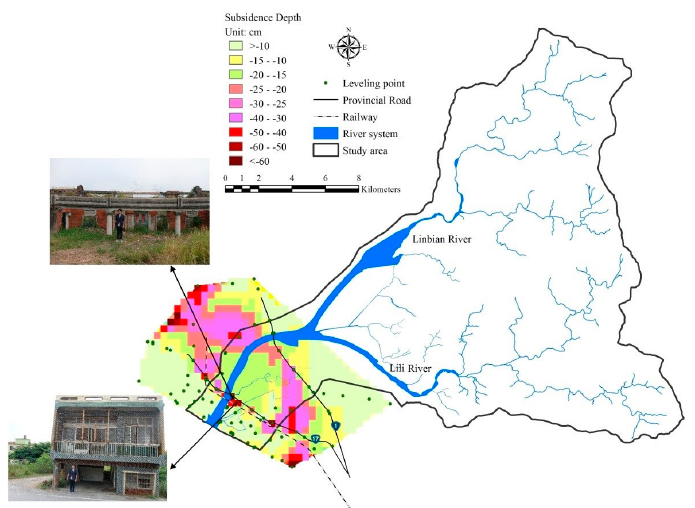
Figure 3. Linbian River land subsidence inspection point distribution and accumulated land subsidence numerical